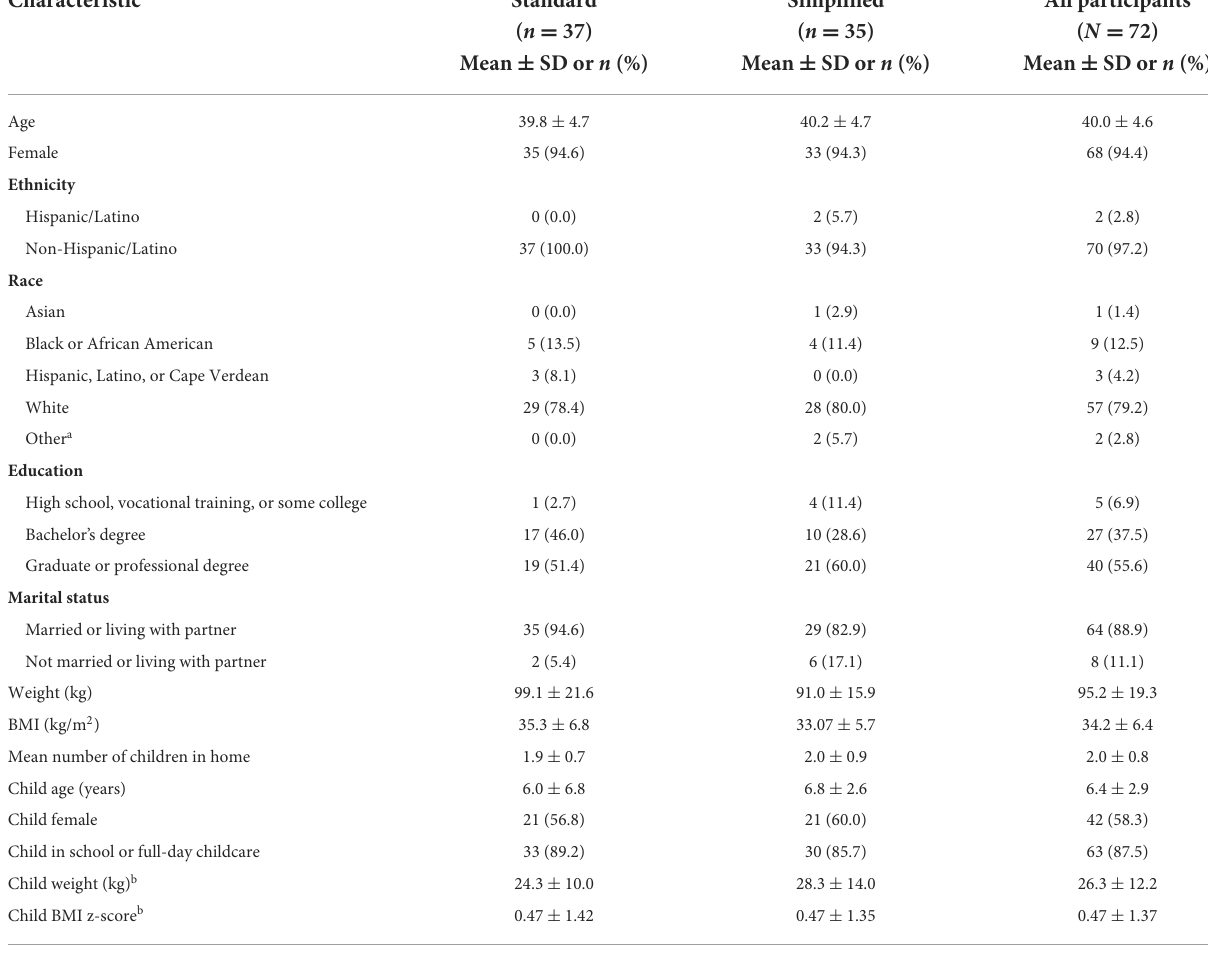
TABLE 1 Baseline characteristics by treatment